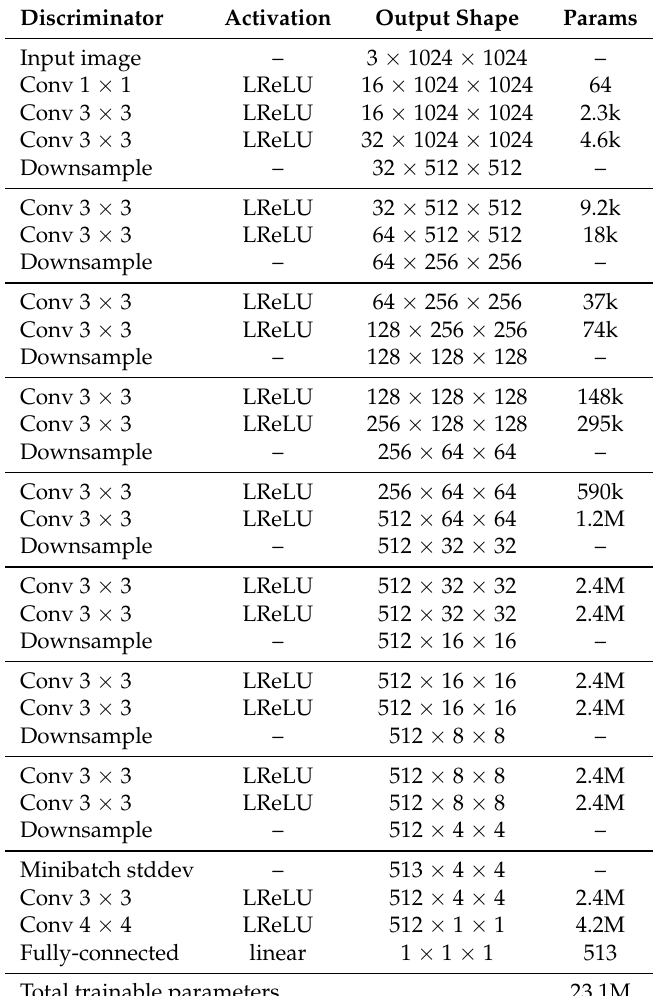
Table 1. Discriminator architecture of the StyleGAN neural network